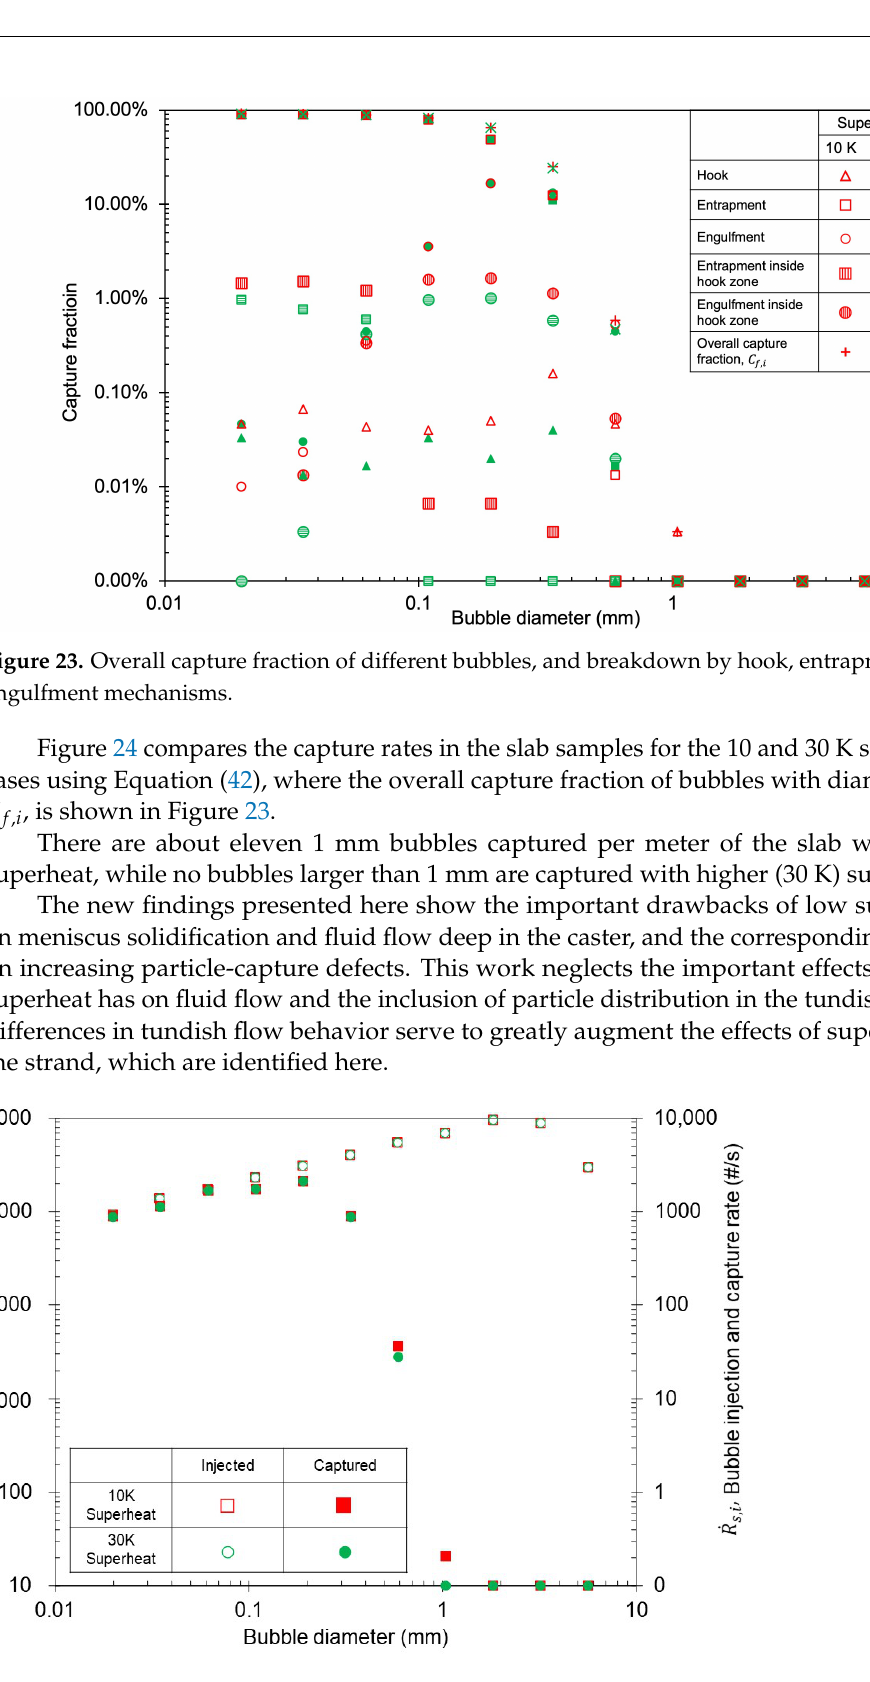
Figure 24. Injection and capture rates for all bubble